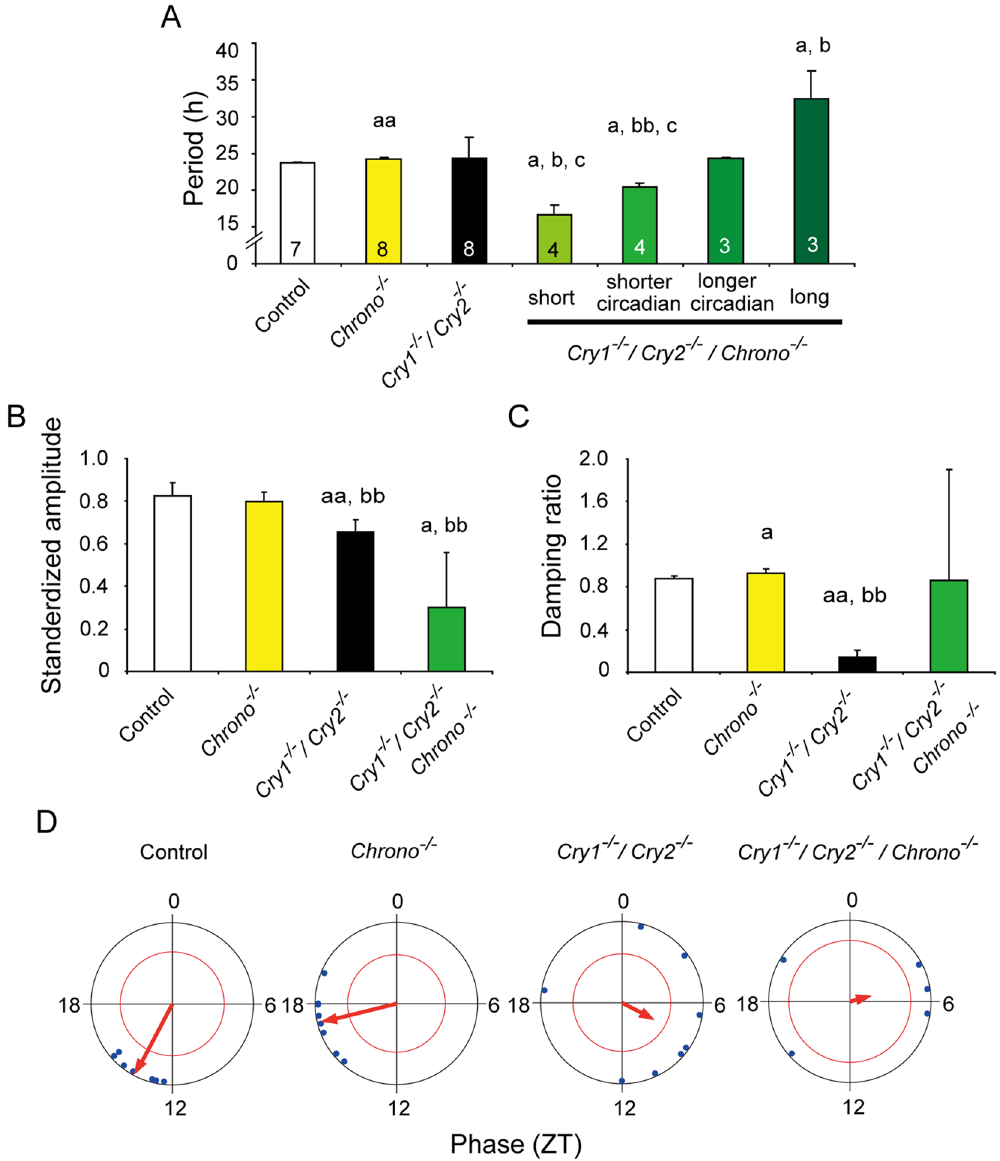
Figure 3. Rhythm properties of neonatal SCN in culture from the control, Chrono KO, Cry1/Cry2 deficient, and Cry1/Cry2 / Chrono triple-KO mice. ( A ) Mean periods of PER2::LUC rhythms with standard deviations (SD) calculated by periodogram are shown as columns and vertical lines. A number in each column indicates number of SCN examined. ( B ) Mean standardized amplitude of PER2::LUC rhythms are expressed in a bar graph (mean ± SD). ( C ) Damping ratio of PER2::LUC rhythms is also shown in a bar graph (mean ± SD). Statistical comparisons, a; P < 0.05, aa; P < 0.01 vs. control, b; P < 0.05, bb; P < 0.01 vs. Chrono deficient mice, c; P < 0.05, cc; P < 0.01 vs. Cry1/Cry2 deficient mice (Kruskal–Wallis with a post-hoc Steel-test). ( D ) Peak phase of PER2::LUC rhythms in the 1 st day of culture is illustrated as Rayleigh plot. Blue dots indicate the peak times of individual rhythms. Red arrow in each circle indicates the mean circadian phase. A red circle is 95% confidence level. If an arrow extends over the red circle, the distribution of peak phases is regarded as significantly